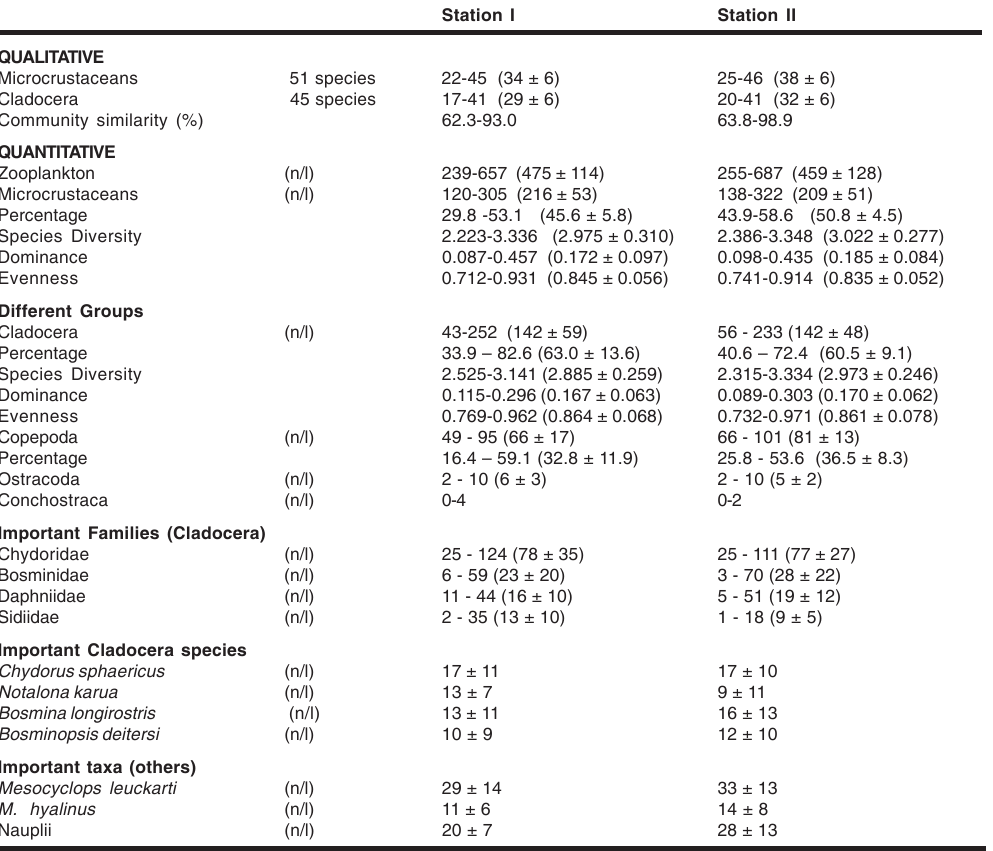
Table 2. Temporal variations of Microcrustacea of Deepor